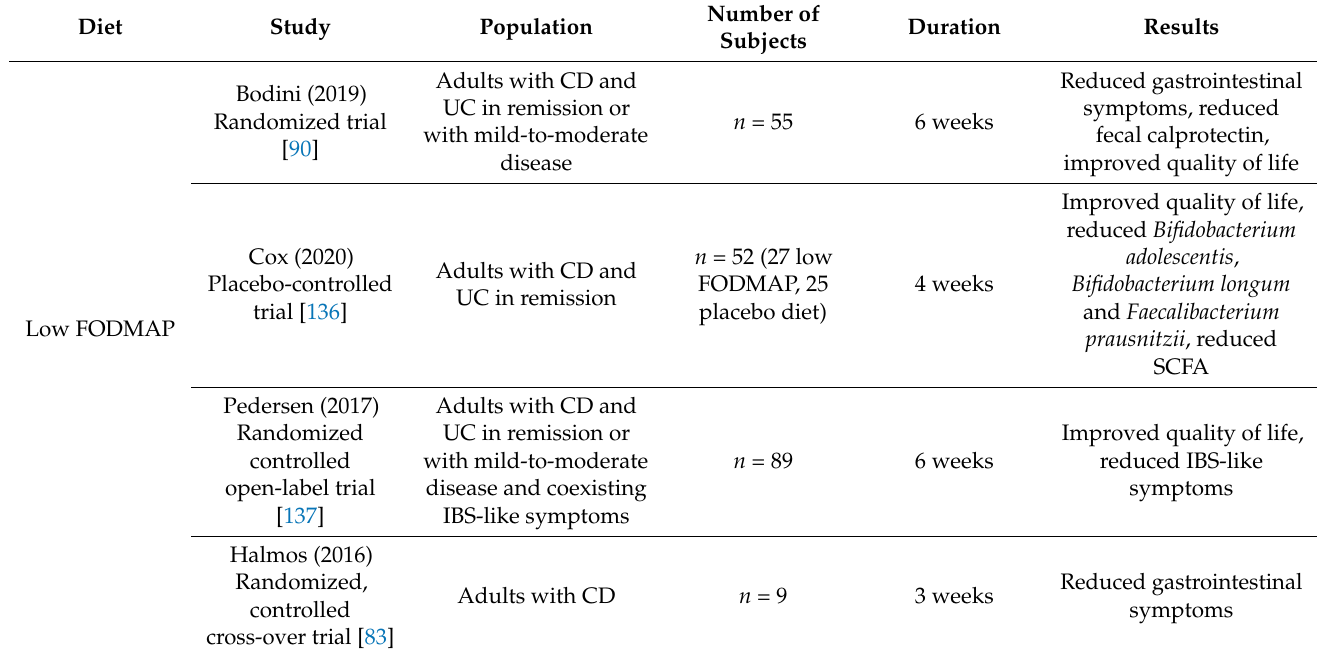
Table 1. Dietary interventions in IBD